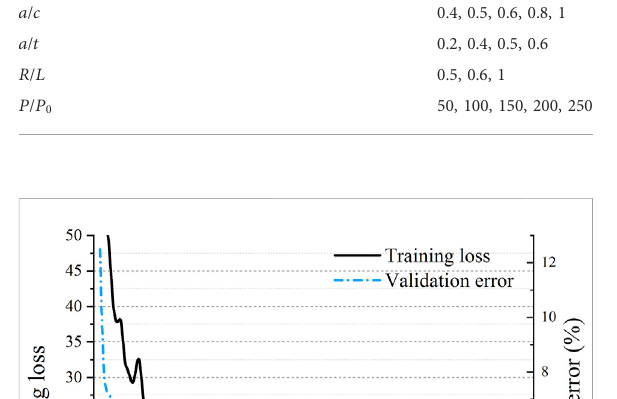
FIGURE 11 Accuracy of